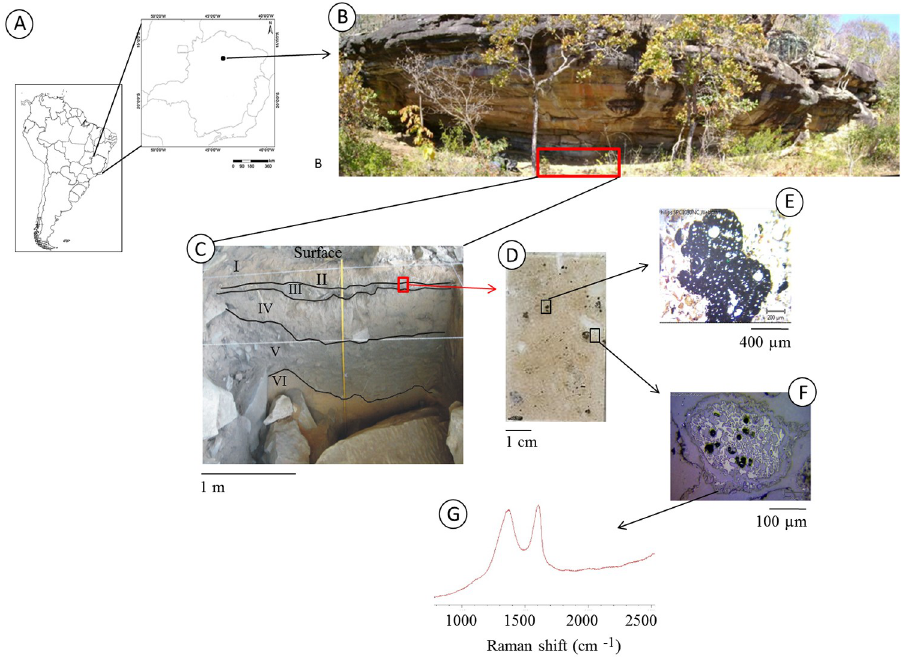
Fig 1. From the meter (landscape and archaeological site) to the micrometer (charcoal particle) scale. A—Location of the sample collection area in South America. B—Archaeological site Bibocas II. The area marked with the red box indicates the excavated site. C—Stratigraphy of the archaeological site with the dating. The black box indicates the location of the thin section samples. D—Micromorphology thin section. The black boxes indicate the locations in which the carbon particles in the transect were analyzed. E—Larger particle of charcoal observed with an optical microscope with transmitted light. F—Smaller particle of charcoal observed with an optical microscope with incident light. G—Example of a Raman spectrum, still untreated, of the smaller-sized charcoal particle (image